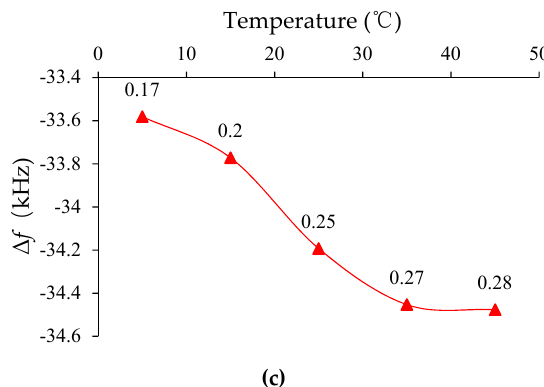
Figure 8. Measured and calculated frequency shift differences caused by temperature. ( a ) Measured frequency shift from QCM-T; ( b ) Measured frequency shift from QCM-R; ( c ) Calculated frequency shift caused by the conductivity.